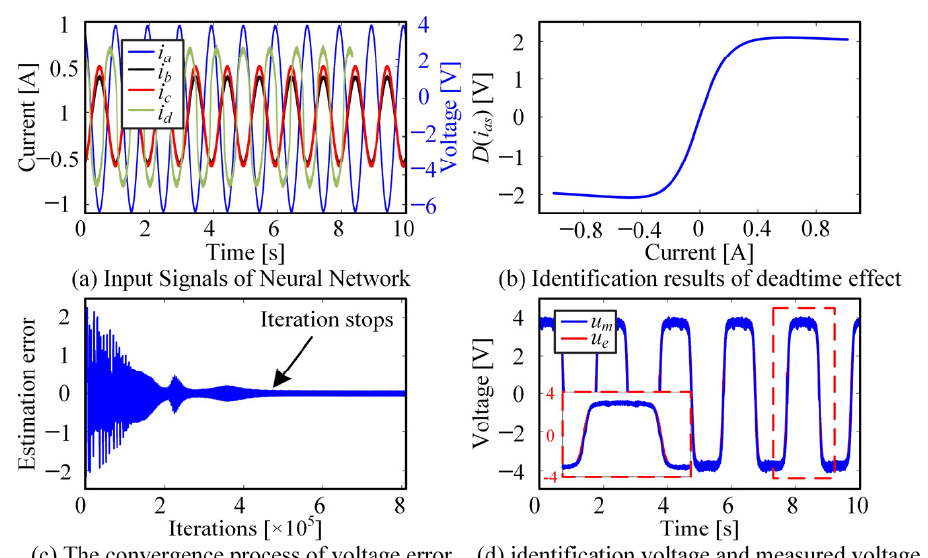
Figure 10. Influence of negative current with different amplitudes on the drain source voltage.